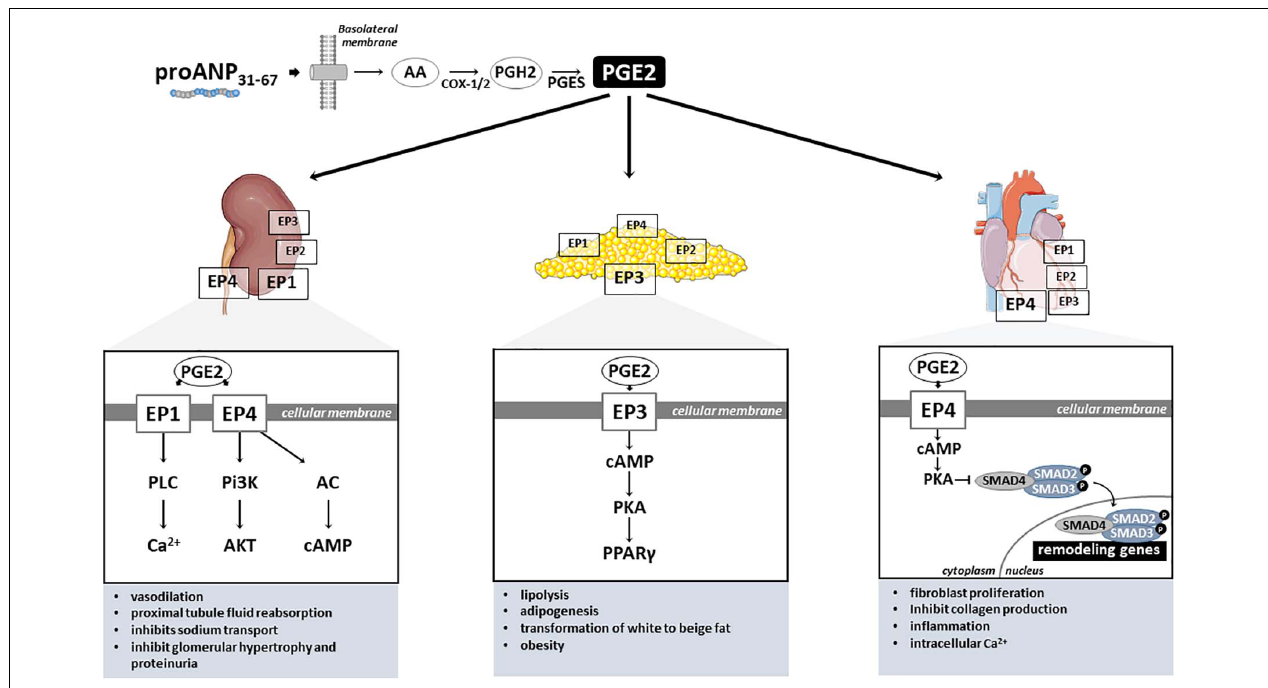
FIGURE 2 | PGE 2 -mediated proANP 31 − 67 cardiac, renal and metabolic mechanisms of action. PGE 2 , Prostaglandin E2; EP1–4, PGE 2 receptors (coupled to G q ); AA, Arachidonic acid; COX-1/2, Cyclooxygenase-1 and –2; PGH2, Prostaglandin H2; PGES, Prostaglandin E synthase; PLC, Phospholipase C; Pi3K, Phosphoinositide 3-kinases; AC, Adenylate cyclase; Ca 2 + , Calcium ion; AKT, protein kinase B; cAMP, Adenosine 3 (cid:48) ,5 (cid:48) -cyclic monophosphate; PKA, protein kinase A; SMAD2–4, SMAD (Mothers against decapentaplegic) family member 2, 3, and 4; PPAR γ , Peroxisome proliferator-activated receptor